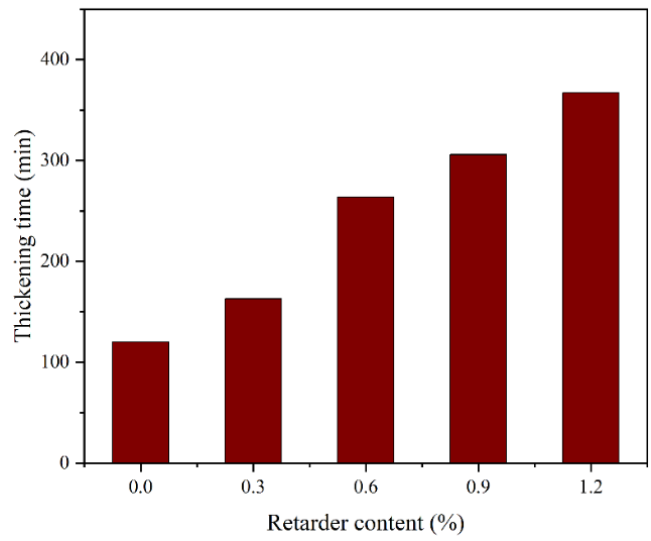
Figure 7. Thickening time versus retarder content.